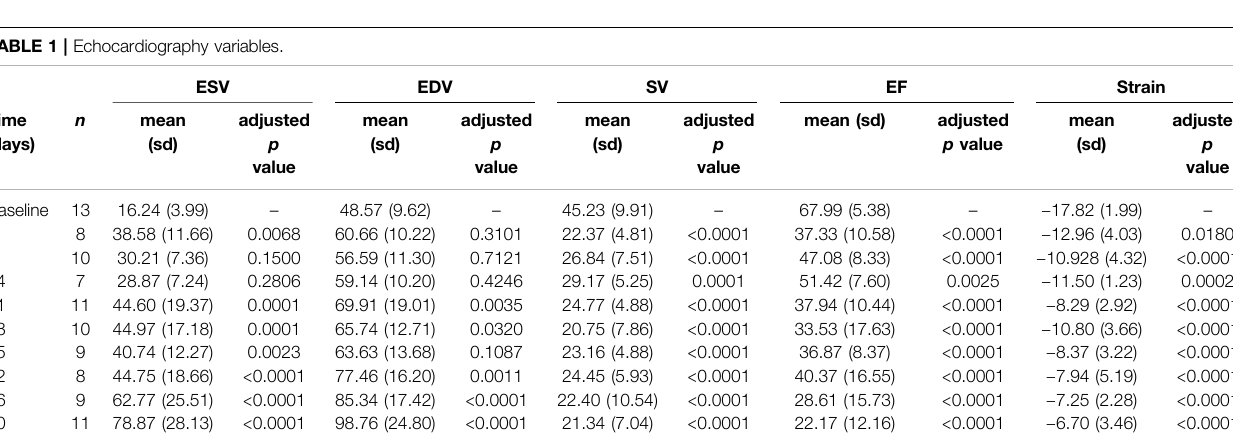
TABLE 1 | Echocardiography